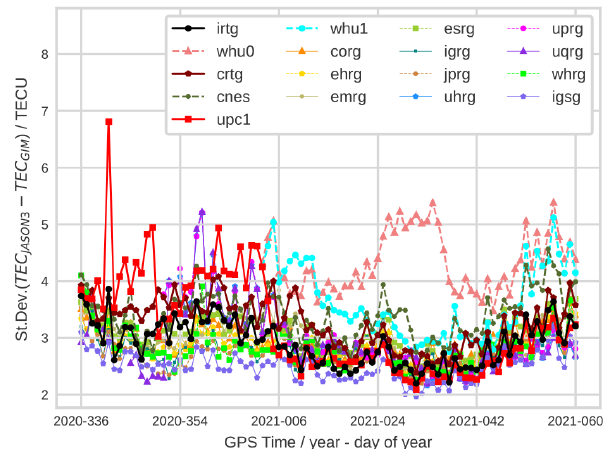
Figure 3. Daily standard deviation of GIM VTEC versus measured Jason-3 VTEC (in TECU), from 1 December 2020 to 1 March